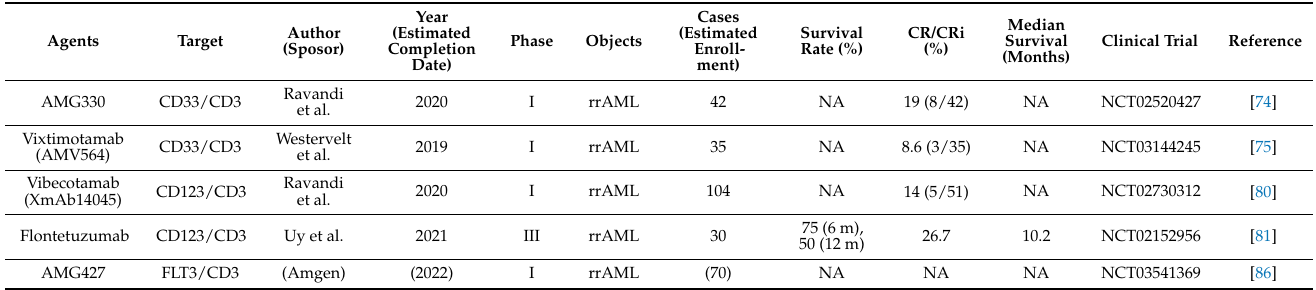
Table 2. Summary of recent clinical trials of bispecific antibodies in AML and/or